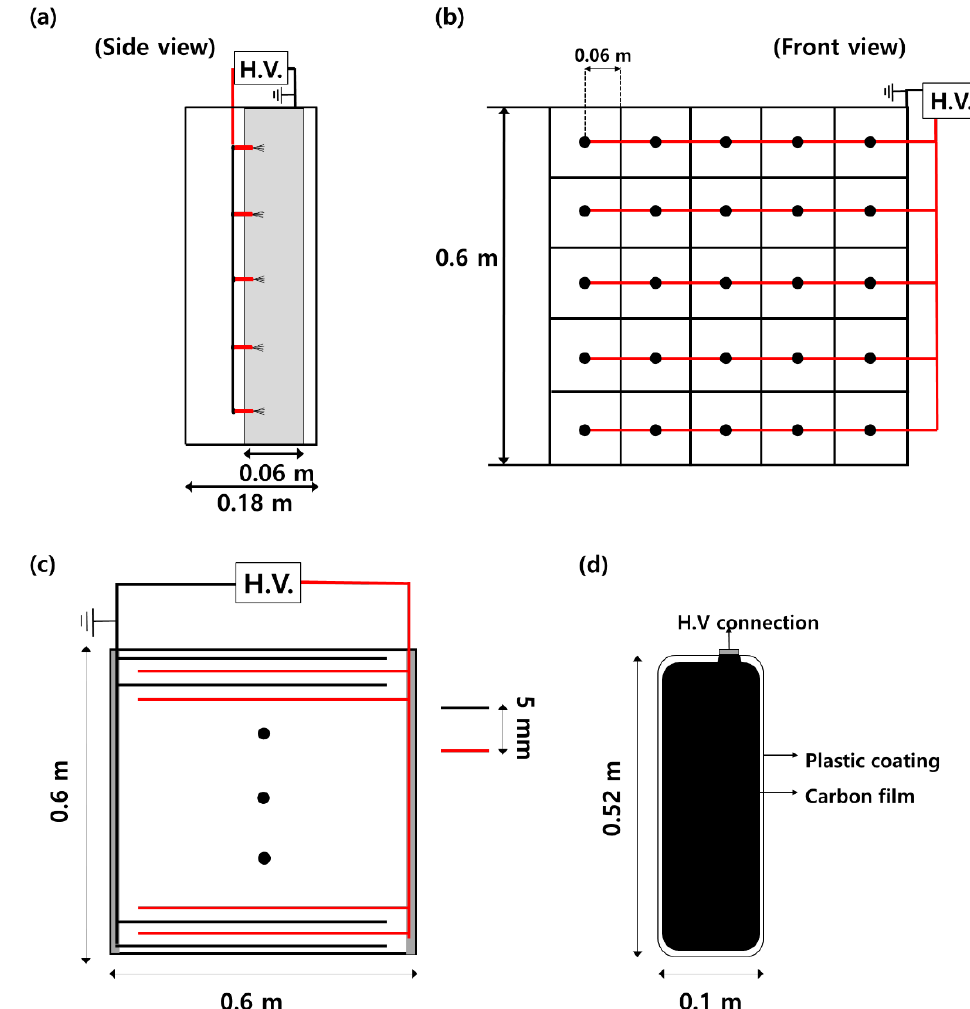
Figure 2. Schematic of the charger and collector of the two-stage electrostatic precipitator: ( a ) Side view of the charger; ( b ) Front view of the charger; ( c ) Front view of the collector; ( d ) High-voltage electrode of the collector (carbon film coated with plastic).